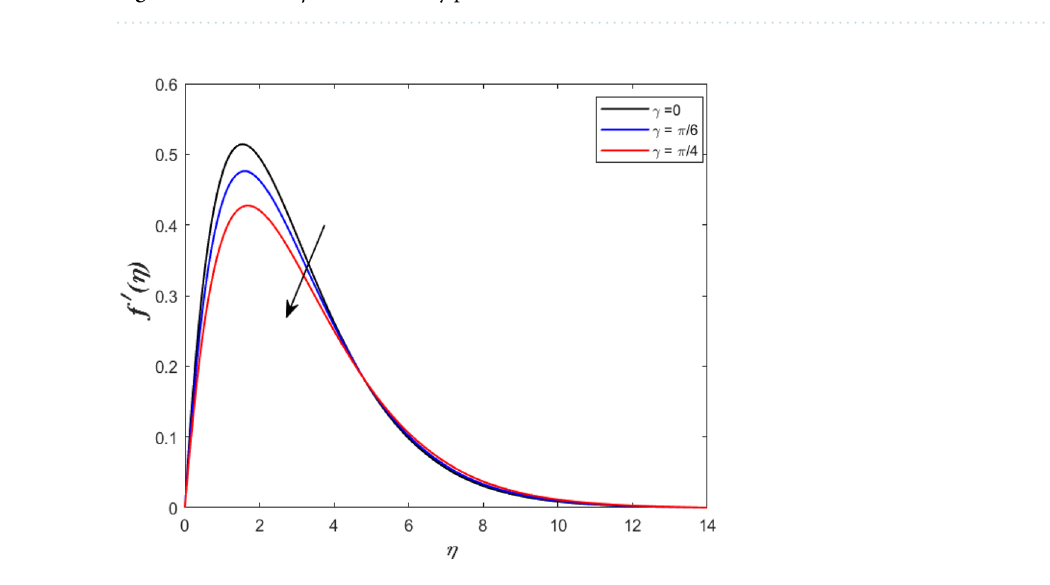
Figure 10. Effect of β on the velocity profile.